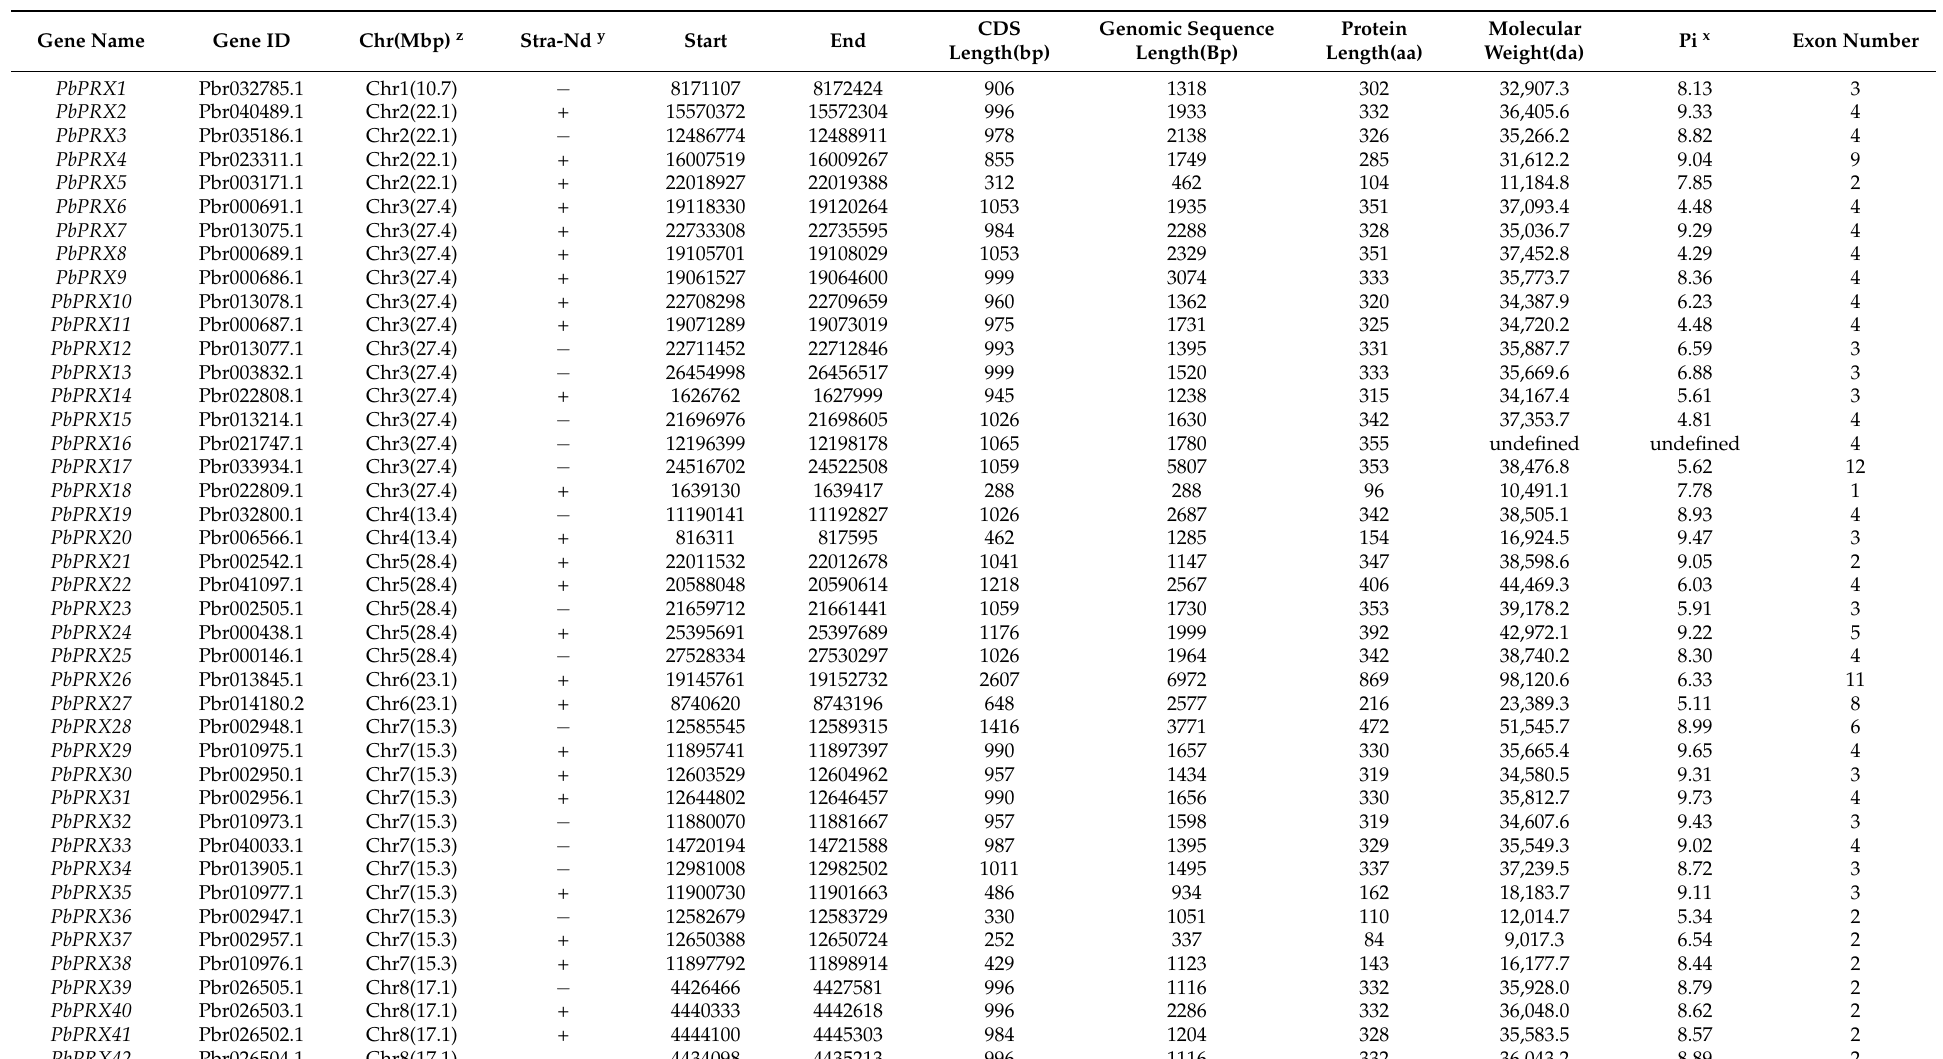
Table 1. Structural and biochemical information of members of PbPRX gene family in